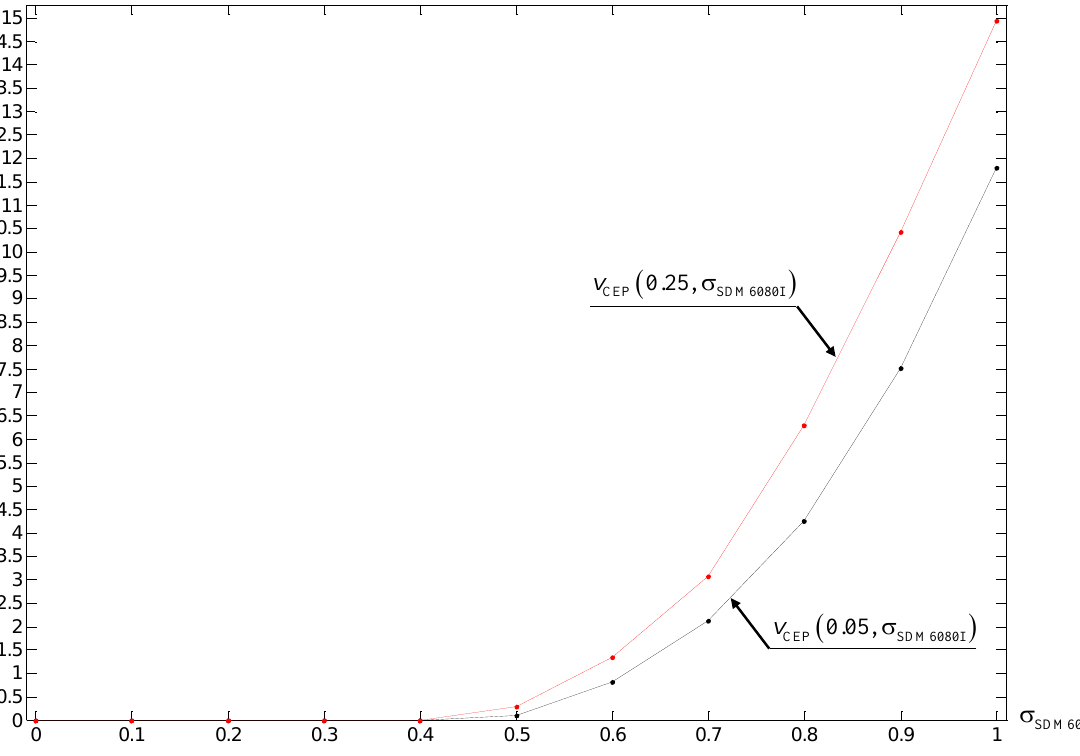
Fig. 8. Evaluation of the function 